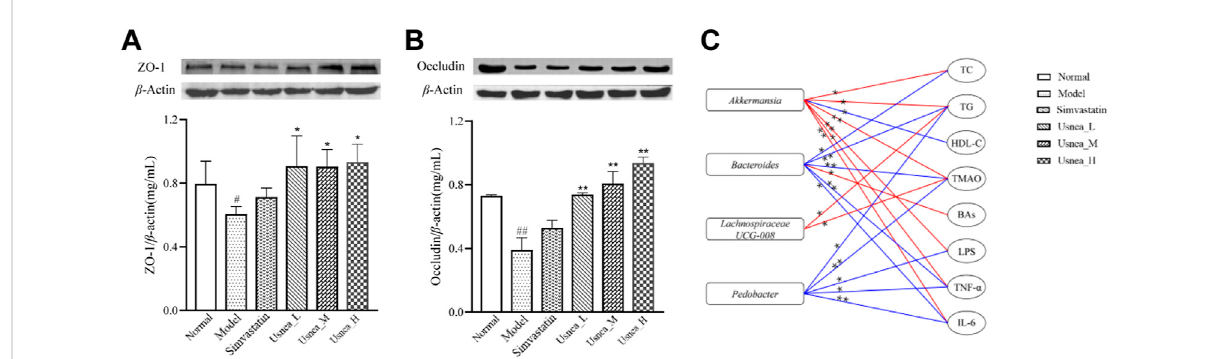
FIGURE 11 UEE affected the concentrations of occludin and ZO-1. (A) UEE increased the expression of ZO-1; (B) UEE increased the concentration of occludin; and (C) potential correlation analysis between the intestinal fl ora associated with AS and pharmacokinetic markers. Rectangles represent the intestinal fl ora related to AS; circles denote pharmacokinetic markers; red indicates a positive association, whereas blue indicates a negative correlation. Results are expressed as the mean ± SD ( n = 3 per group). * p < 0.05, ** p <